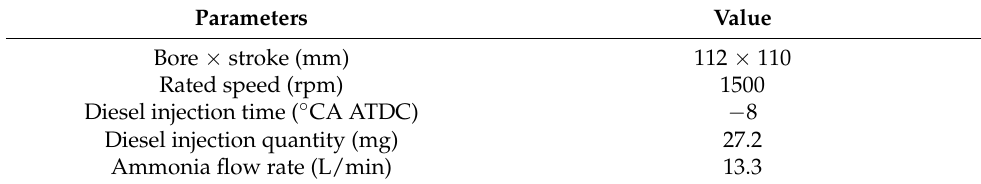
Table 3. Engine structure and operating